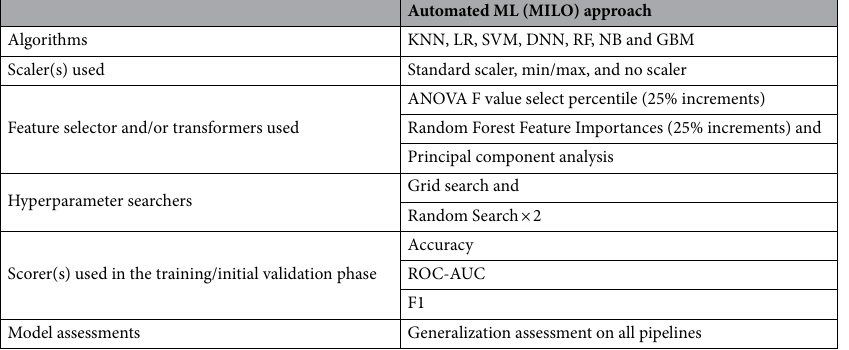
Table 2. Core features of MILO classification algorithms. Seven of the most widely validated and adopted algorithms (deep neural network (DNN), logistic regression (LR), Naïve Bayes (NB), k-nearest neighbors (k-NN), support vector machine (SVM), random forest (RF), and XGBoost gradient boosting machine (GBM)) are used in the pipelines generated in MILO’s automated approach, which also includes several hyperparameter tuning/search tools such as random search tool × 2 in addition to our custom grid